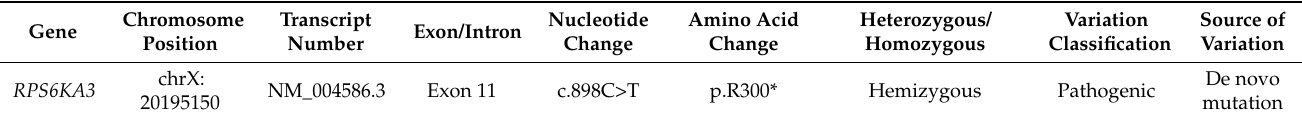
Table 3. Child 2 sequencing